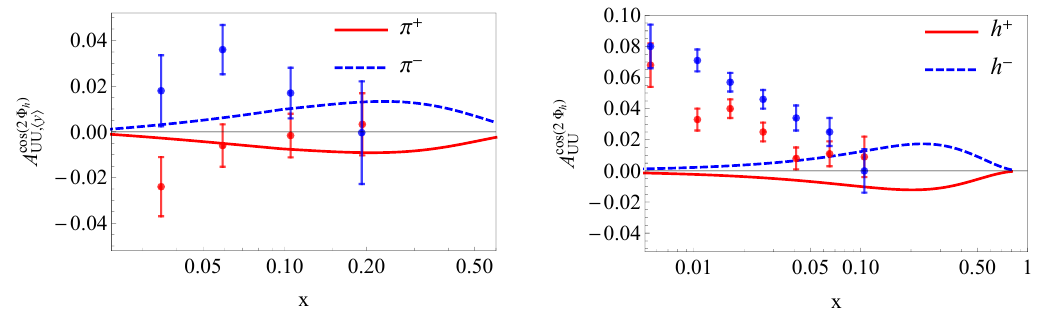
Figure 8. The asymmetry A cos(2 (cid:30) h ) for a proton target as function of x based on the (cid:12)t [157] in UU; h y i comparison to (left panel) HERMES [158] and A cos(2 (cid:30) h ) (right panel) COMPASS data UU